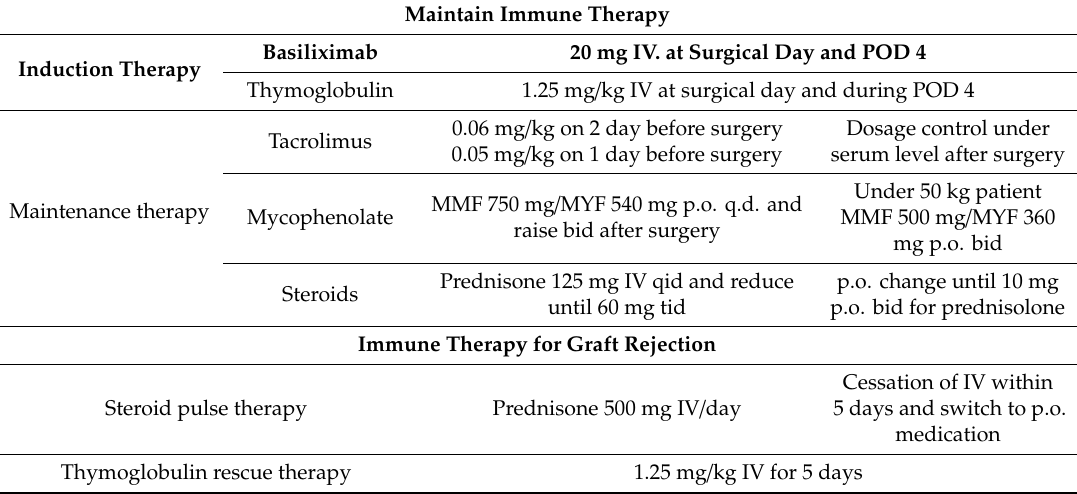
Table 1. Immunosuppressive regimen in living donor kidney